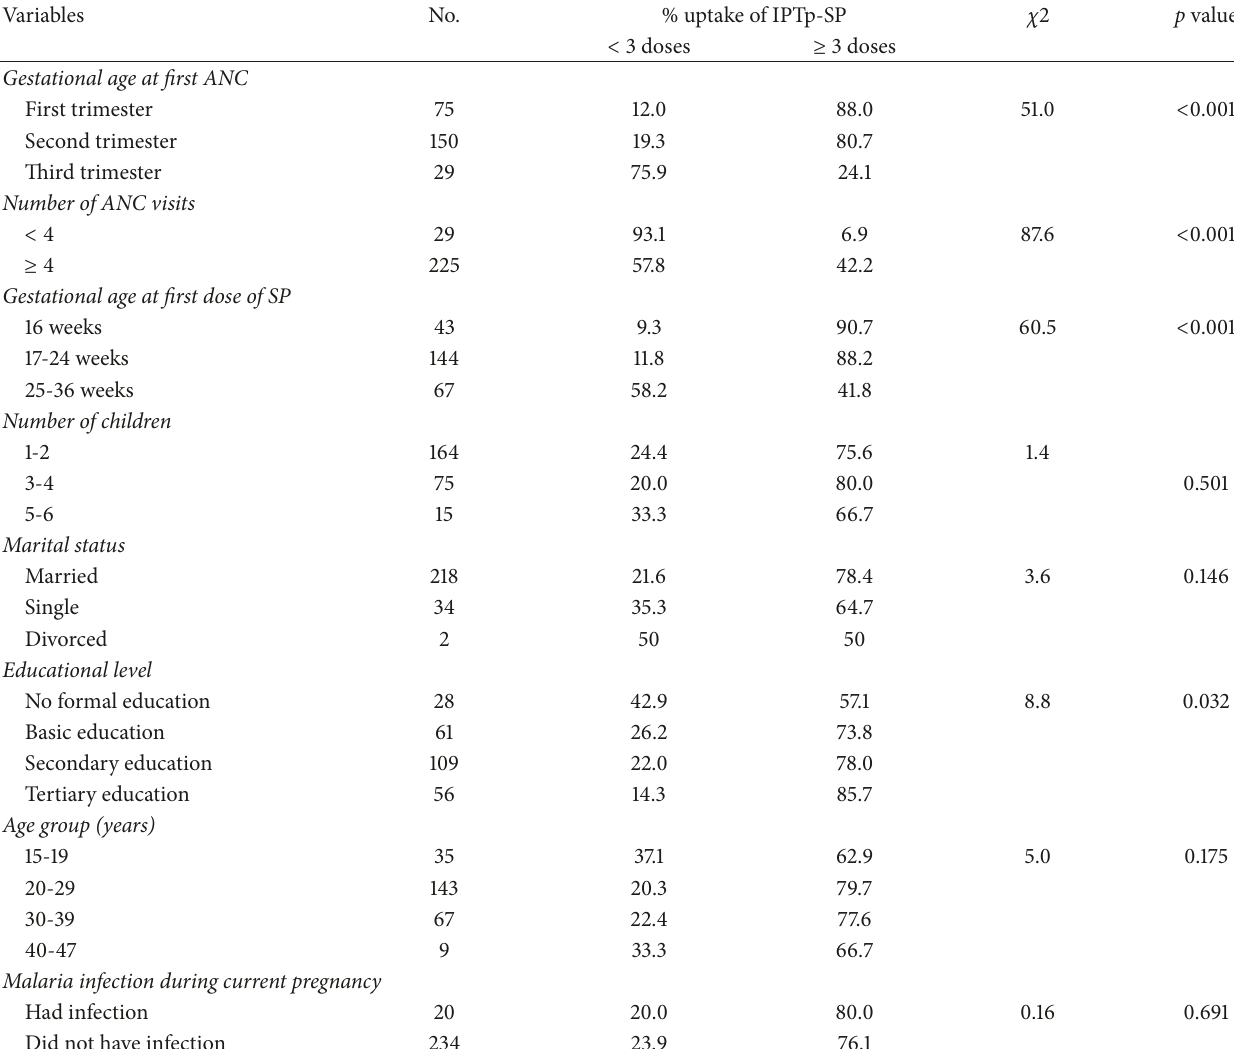
Table 3: Relationship between ANC visits, sociodemographic characteristics, IPTp-SP uptake, and malaria infection among women that had recently